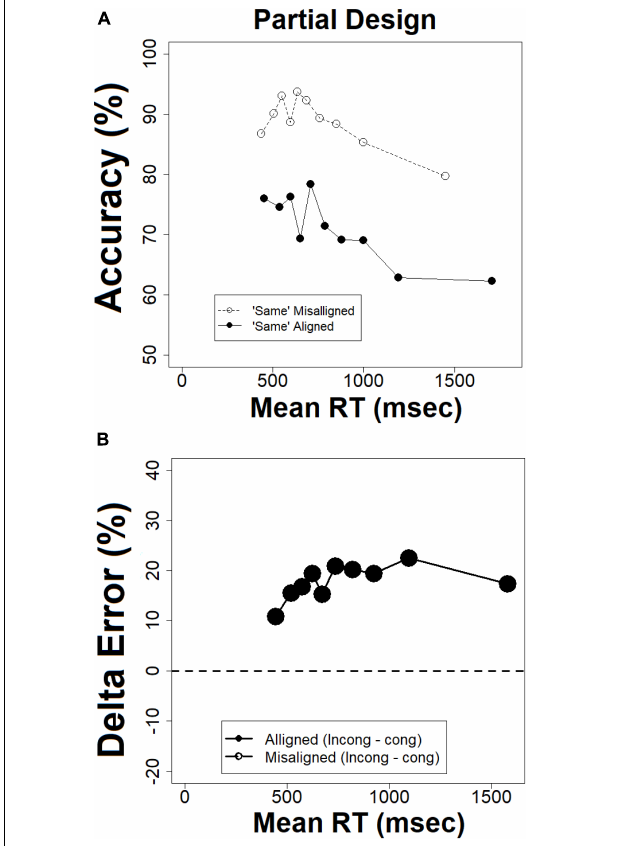
FIGURE 9 | (A) Conditional accuracy functions in the partial design, (B) delta plots for error rates in the partial design, the abscissa = (mean RT congruent + mean RT